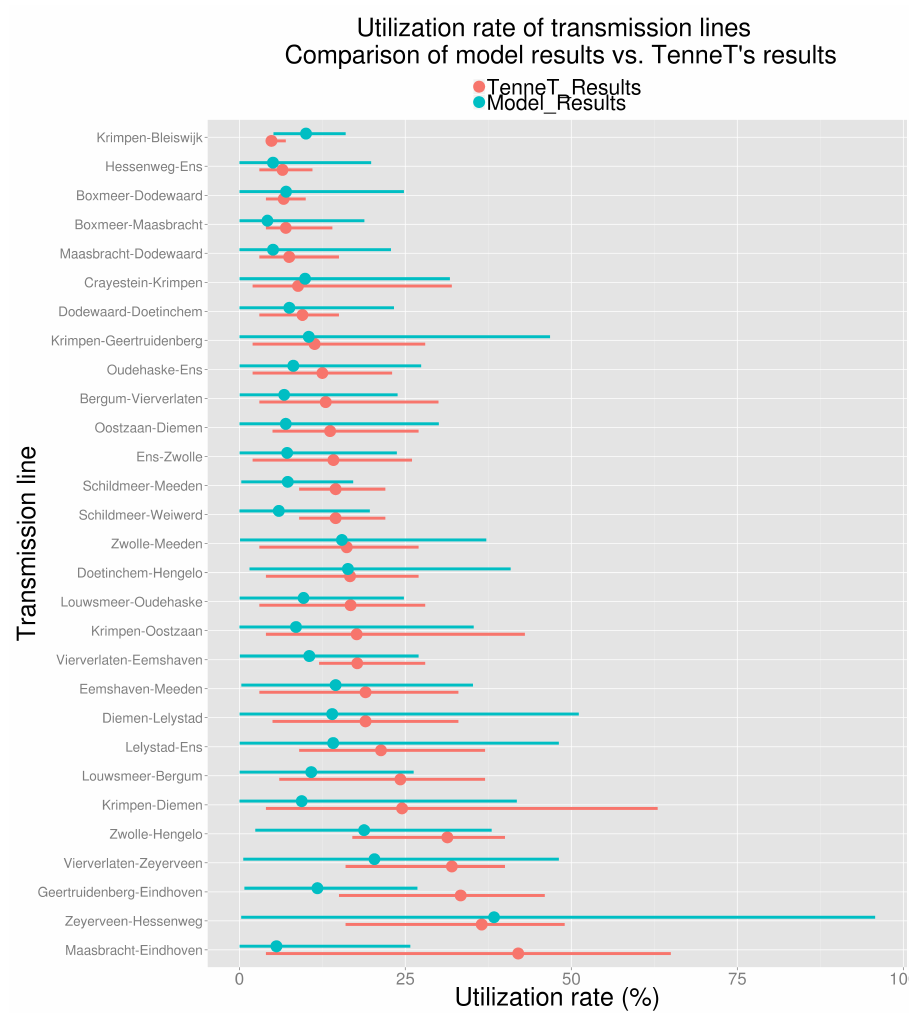
Figure 9. Comparison of results of the developed model to the results of TenneT’s calculations as published in TenneT (2009). Circles represent the mean utilization rate of the respective transmission lines. The ends of the horizontal lines represent the minimum and maximum utilization rates. The model results generally underestimate the utilization rate of transmission lines under no-fault conditions, but capture the range of observed utilization rates relatively